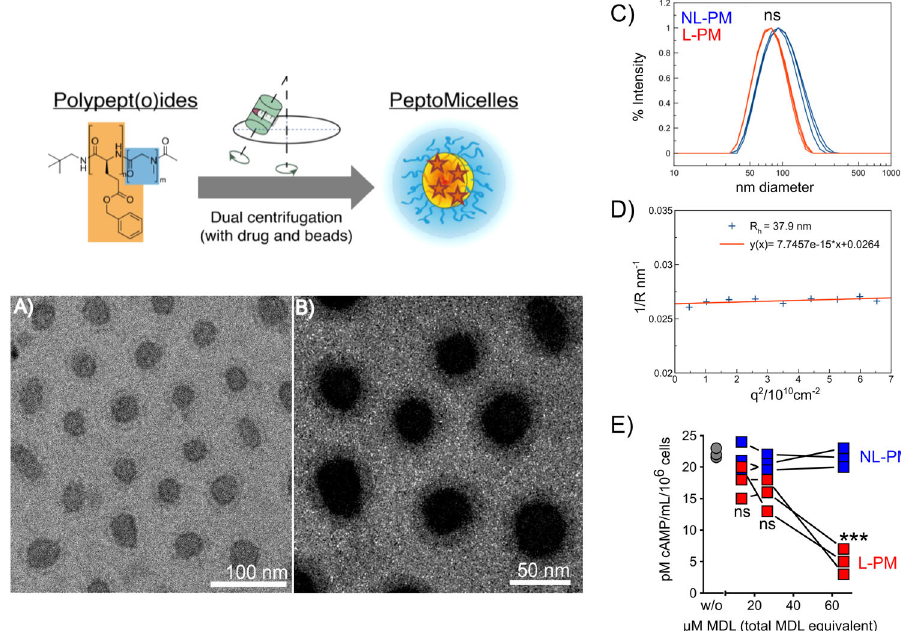
Fig. 1 MDL-loaded polypept(o)ide micelle properties. Schematic representation of polypept(o)ide micelle synthesis and inhibitor loading. A Cryo TEM images of MDL-loaded micelles at 1 mg/mL and B a magni fi cation with optimized contrast after applying a Gaussian blurr effect with ImageJ to increase the visibility of the corona layer. C Single-angle DLS measurement of un fi ltered solutions of empty (NL-PM, blue) and loaded (L-PM, red) micelles directly after centrifugation ( n = 3; diameter differences were statistically nonsigni fi cant P = 0.69 (unpaired Mann – Whitney test, two-sided, 0.95 con fi dence interval, signi fi cance level 0.05. D Multi-angle DLS data of L-PM to verify and back up zetasizer data. E Dose-dependent repression of intracellular cAMP levels in murine B16 cells, 4 h after incubation with different amounts of L-PM or NL-PM micelles. Results shown as mean ± SEM, n = 3 per treatment/ dose, *** P = 0.003 (66 µ M) (unpaired t -test with Holm – Š ídák-corrected P values, alpha = 0.05, 0.95 con fi dence interval). ns = nonsigni fi cant. Each image and graph representative of n = 3 independent experiments. Table 1 Characterization of MDL-loaded and non-loaded polypept(o)ide micelles. Diameter (nm)